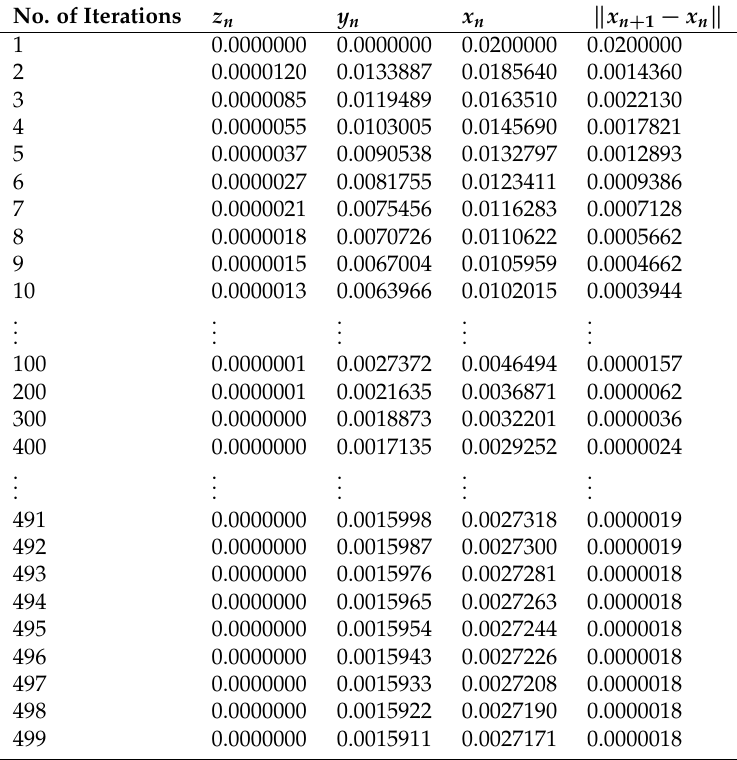
Table 1. Values of z n , y n and x n .